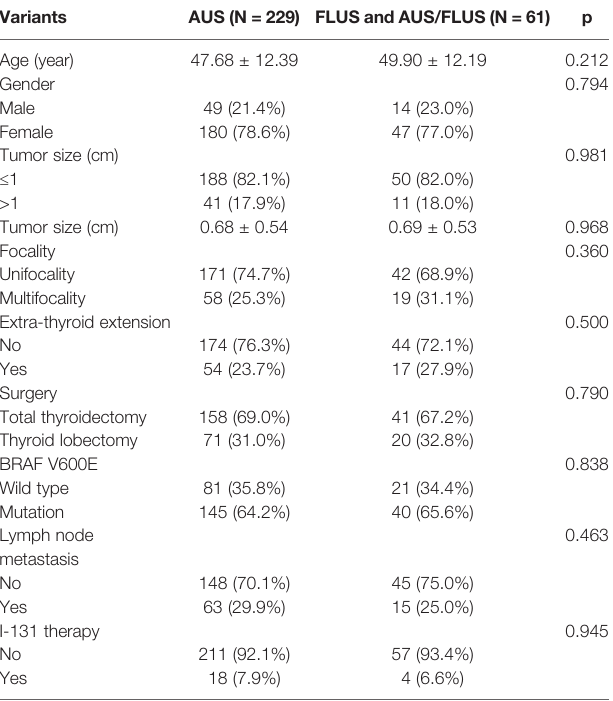
One patient with the status of extra-thyroid extension remaining unknown was excluded. Nineteen patients with the status of lymph node metastasis remaining unknown were excluded. Three patients with the status of BRAF V600E mutation status remaining unknown were